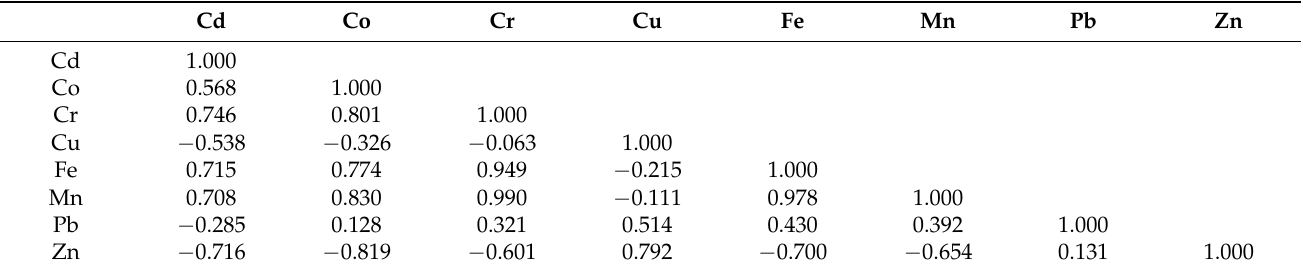
Table 5. Correlations between heavy metal concentrations of tested leafy